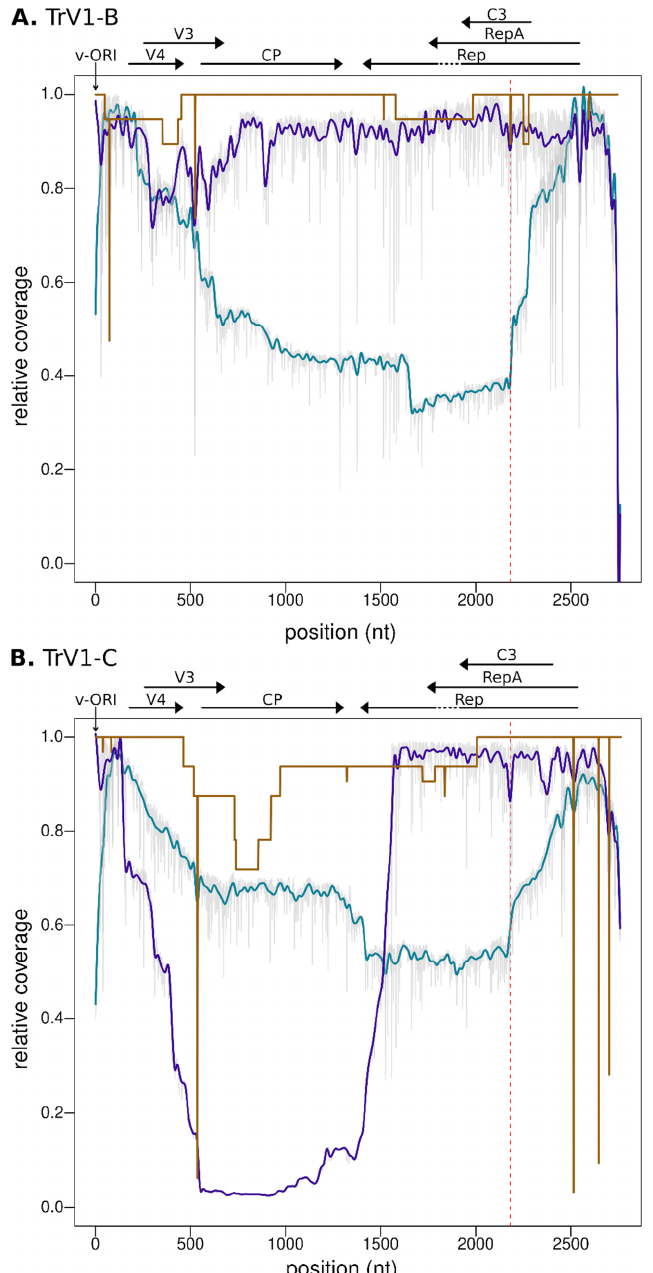
Figure 4. Coverage plot along the reference genome of TrV1-B ( A ) and TrV1-C ( B ). The coverage, interpreted here as the fold coverage of a given position divided by the maximum coverage of the whole genome, is represented with a brown line for Sanger sequences, a blue line for RCA-MinION sequences and a purple line for PCR-MinION sequences. MinION coverage are interpolations of the raw coverages presented here in grey on the background. The position of the abutting primers used in the PCR-MinION procedure is indicated by the vertical red dotted line. Positions are relative to the reference genome MW698819 for TrV1-B and MW698820 for TrV1-C. ORFs of these reference genomes are symbolized with horizontal arrows on top of the figure. The Origin of replication is indicated with an arrow. The position 1 of each sequence correspond to the nick-site within the stem loop